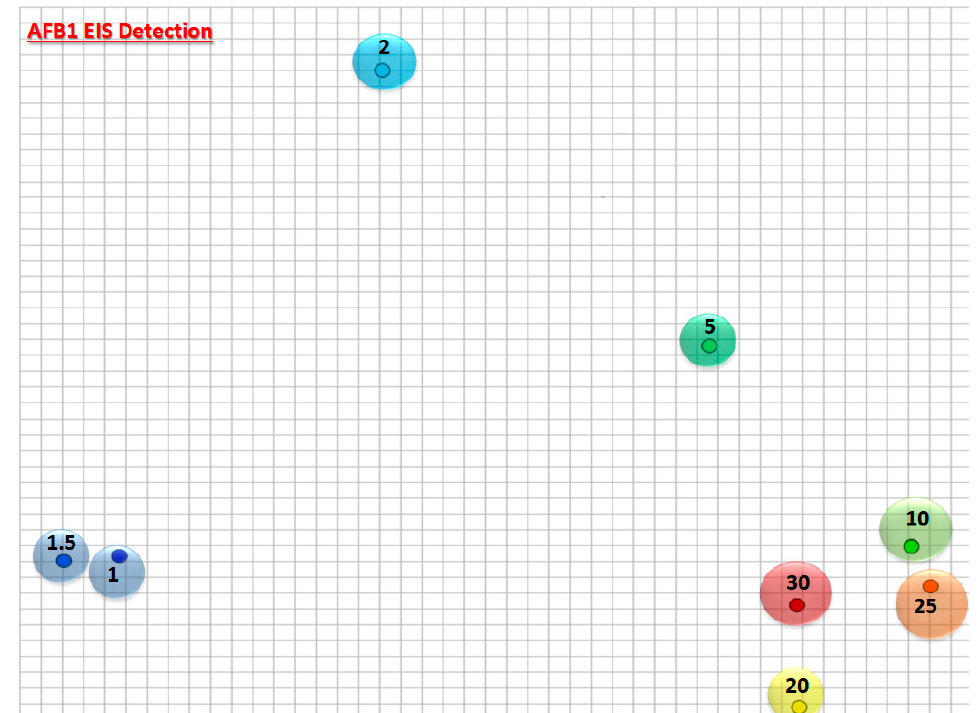
Figure 6. Interactive document mapping (IDMAP) plot obtained from the Nyquist plot of the different AFB1 concentration.